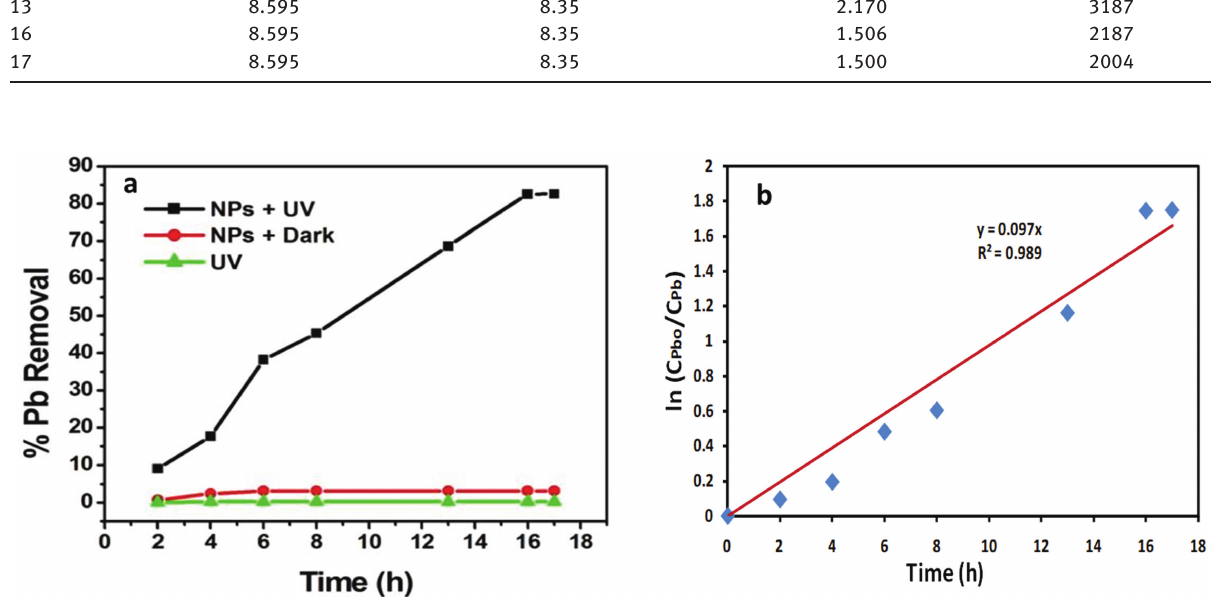
NPs; (b) Kinetic data for Pb removal with 2